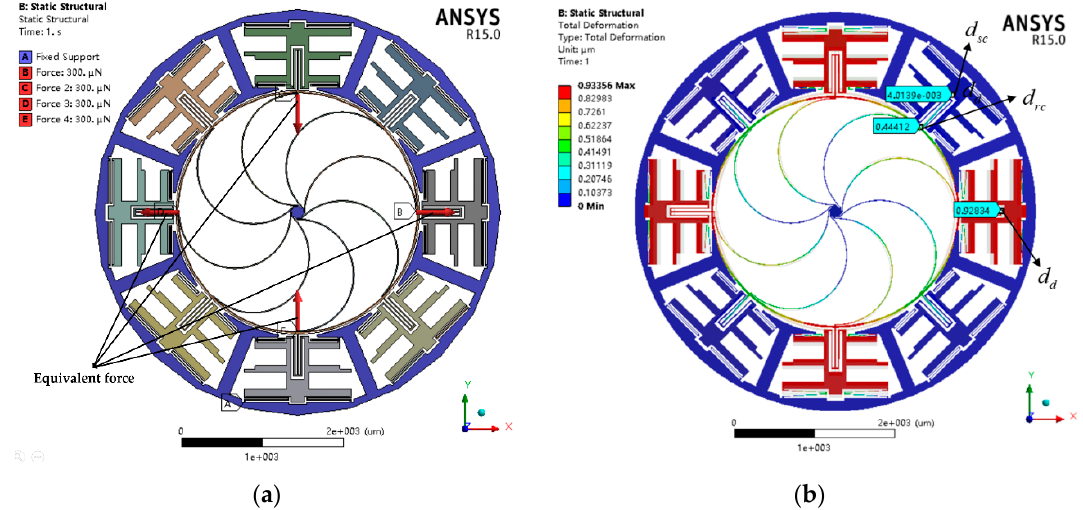
Figure 9. The predefined environments ( a ) and total deformation with a magnification of 50 times ( b ) when the equivalent force is 300 μN of nonlinear analysis.